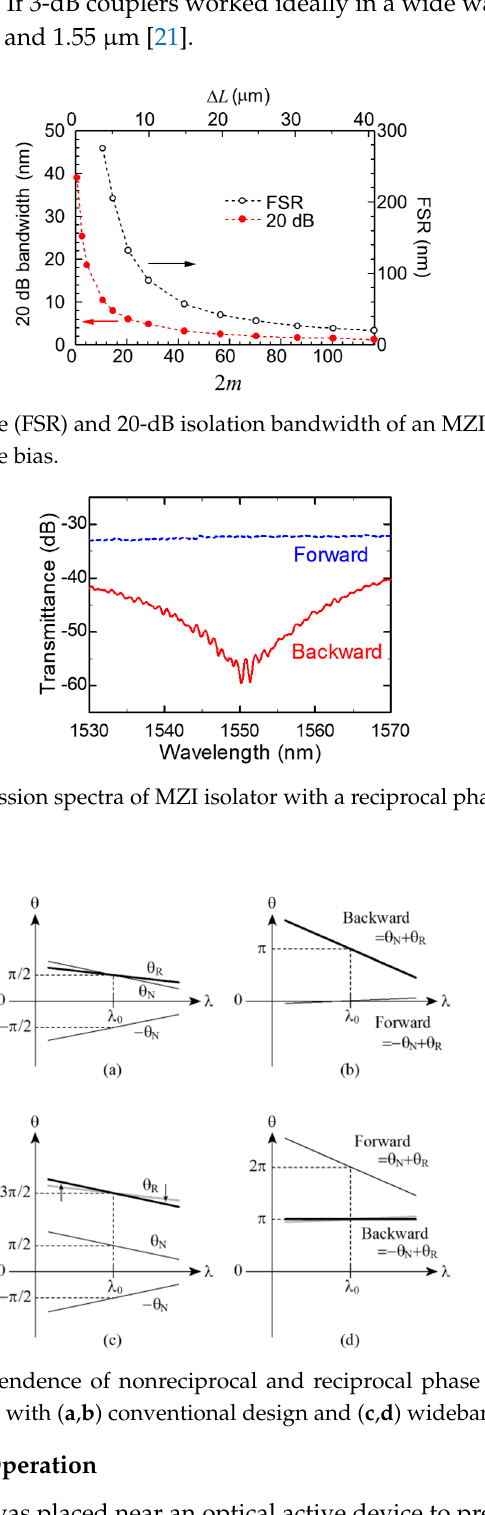
Figure 5. Wavelength dependence of nonreciprocal and reciprocal phase differences, θ N and θ R , respectively, of MZI isolator with ( a ), ( b ) conventional design and ( c ), ( d ) wideband design.